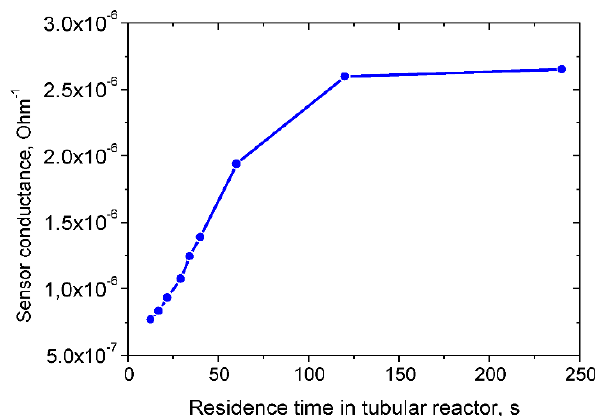
Figure 5. Metal oxide sensor conductivity as a function of carrier gas (air) residence time in membrane unit. Concentration of CH 4 in gas bubbled through water is of 1%.